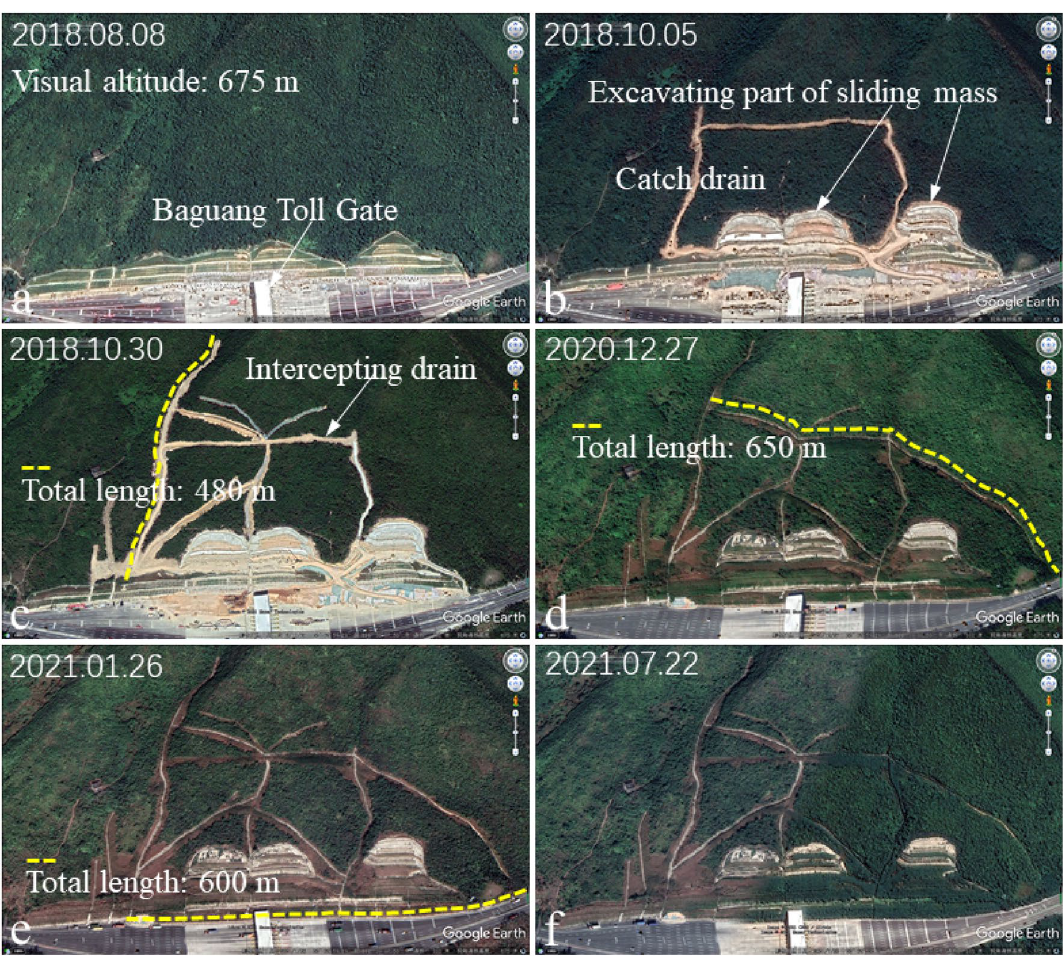
Figure 20. Setting and current situation of intercepting ditches and drainage ditches that block the runoff on slope surface at different time nodes. ( a ) The slope in a critical sliding state after extreme rainfall; ( b,c ) drainage ditch and intercepting ditch set on the mountain above the slope top; ( d ) excavation area covered by vegetation gradually; ( e,f ) current status of the Baguang Toll